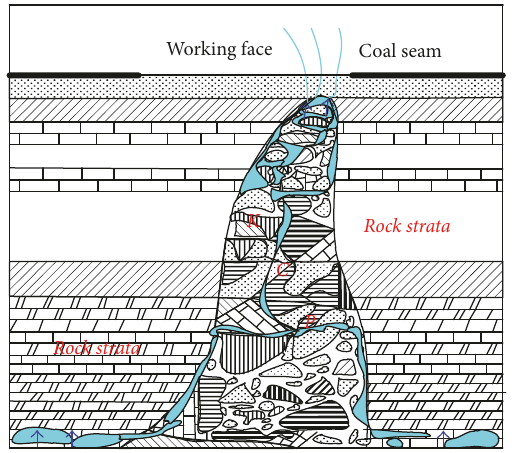
Figure1:IllustrationofaKarstCollapsePillar:frontviewofatypical cone shaped KCP (not to scale) [23] and different shapes of rock layers represent different types of